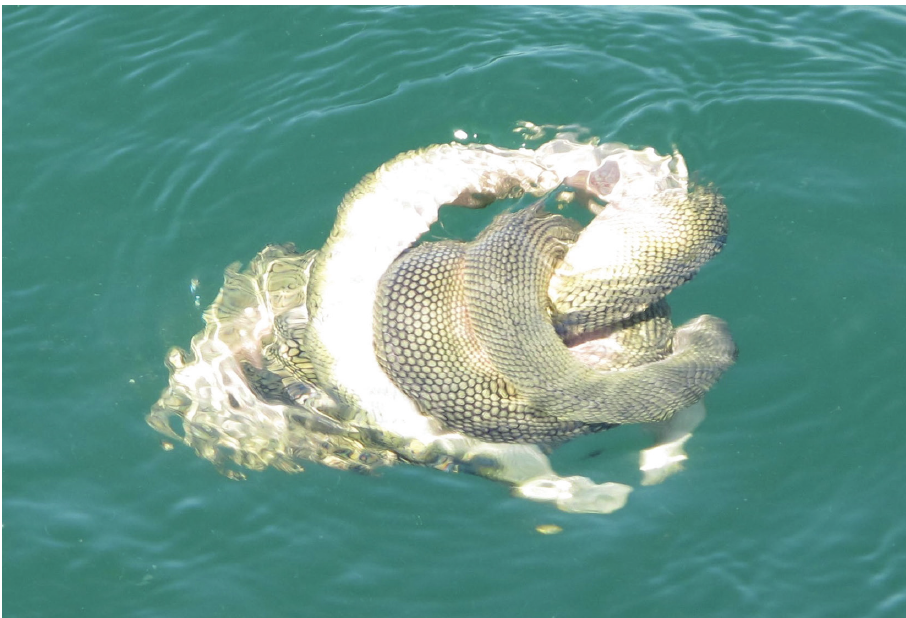
Figure 7. Mating behavior of Hydrophis schistosus : two individuals intertwined each other and floating on the surface in the coastal waters of Jask (western Gulf of Oman), December